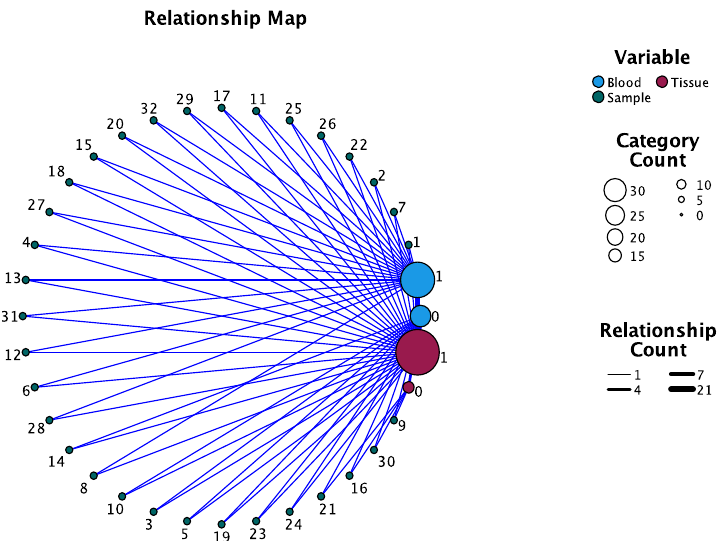
Figure 2. Relationships between the gene variant C/T and tissue and blood samples. The association of the incidence of the T allele within the blood samples of the two sexes was not statistically significant ( p = 0.989, chi-square test) (Table ?? ).